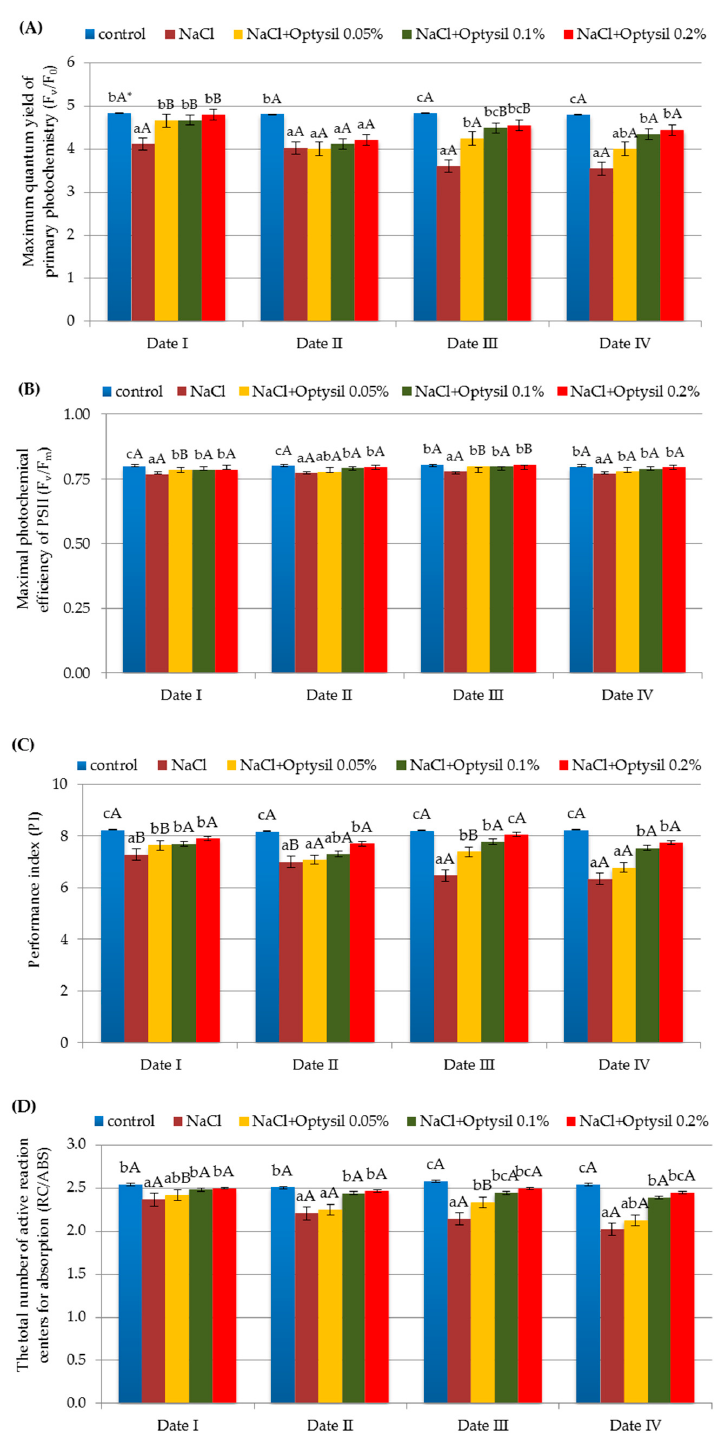
Figure 3. The effect of experiment and measurement date on chlorophyll fluorescence parameters: maximum quantum yield of primary photochemistry (F v /F 0 ) ( A ), maximal photochemical efficiency of PSII (F v /F m ) ( B ), the performance index (PI) ( C ) and the total number of active reaction centers for absorption (RC/ABS) ( D ) in oat plants (Date I and Date II, 2 and 7 days after first Si application; Date III and Date IV, 2 and 7 days after second Si application); statistical data are expressed as mean ± SD values. * Capital letters show significant differences between the means in the measurement dates, and lowercase letters show significant differences between the means at next measurement dates ( p =